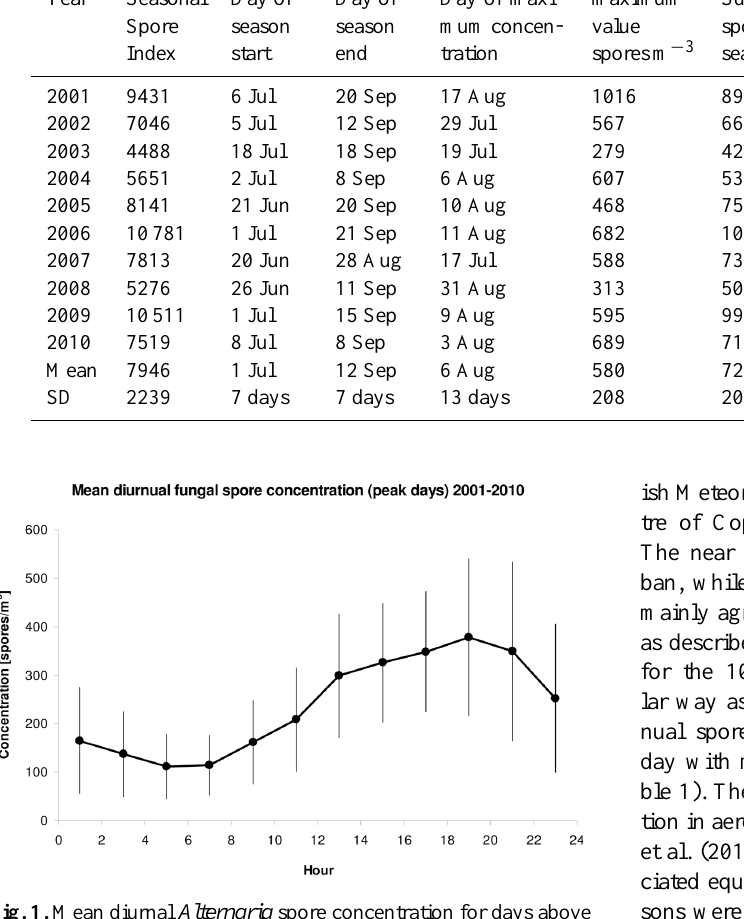
Fig. 1. Mean diurnal Alternaria spore concentration for days above 100sporesm − 3 , n = 232. The error bar for each mean value corre- sponds to 1 standard